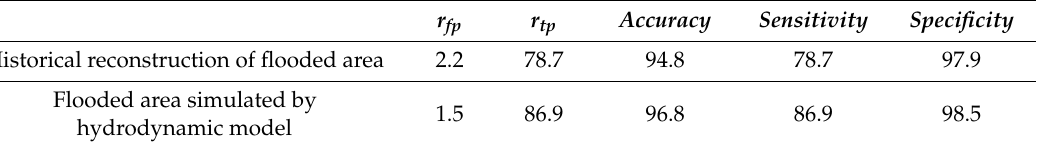
Table 3. Results of the GIS tool performance in terms of the flooded area compared respectively with the results simulated by the hydrodynamic model of Pilotti et al. [36] and obtained from historical reconstruction by Pilotti et al. [36] for the Gleno dam-break case